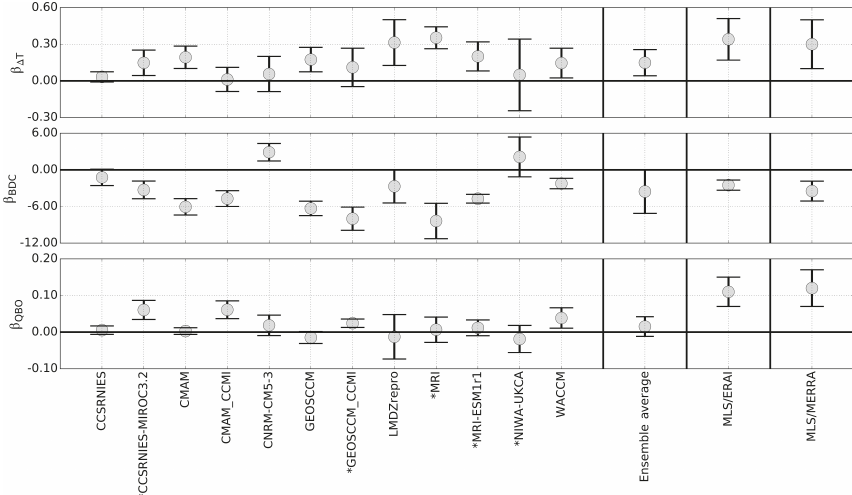
Figure 6. Circles represent the median decadal regression coefficient from each CCM, and error bars correspond to ± 1 standard deviation. An asterisk indicates that the model simulates a QBO. The ensemble mean corresponds to an average of all model coefficients. The ensemble mean coefficients are also represented by a circle, with associated error bars correspond to ± 1 standard deviation of the ensemble set of coefficients. Estimates from observations combined with reanalysis (Dessler et al., 2014) are shown, along with 95th percentile confidence interval. The units of β (cid:49)t , β BDC , and β QBO are ppmvK − 1 , ppmv/(K/day) − 1 , and ppmv, respectively.